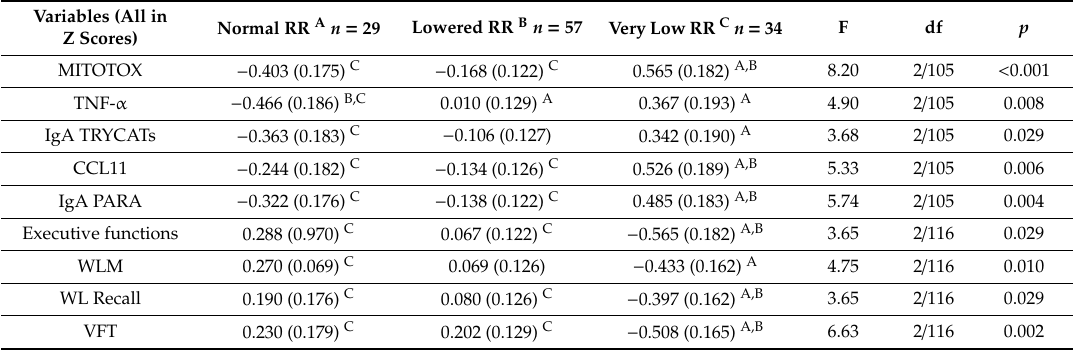
Table 2. Measurements of the adverse outcome pathways (AOPs) and the cognitome in the participants divided according to a risk resilience (RR)